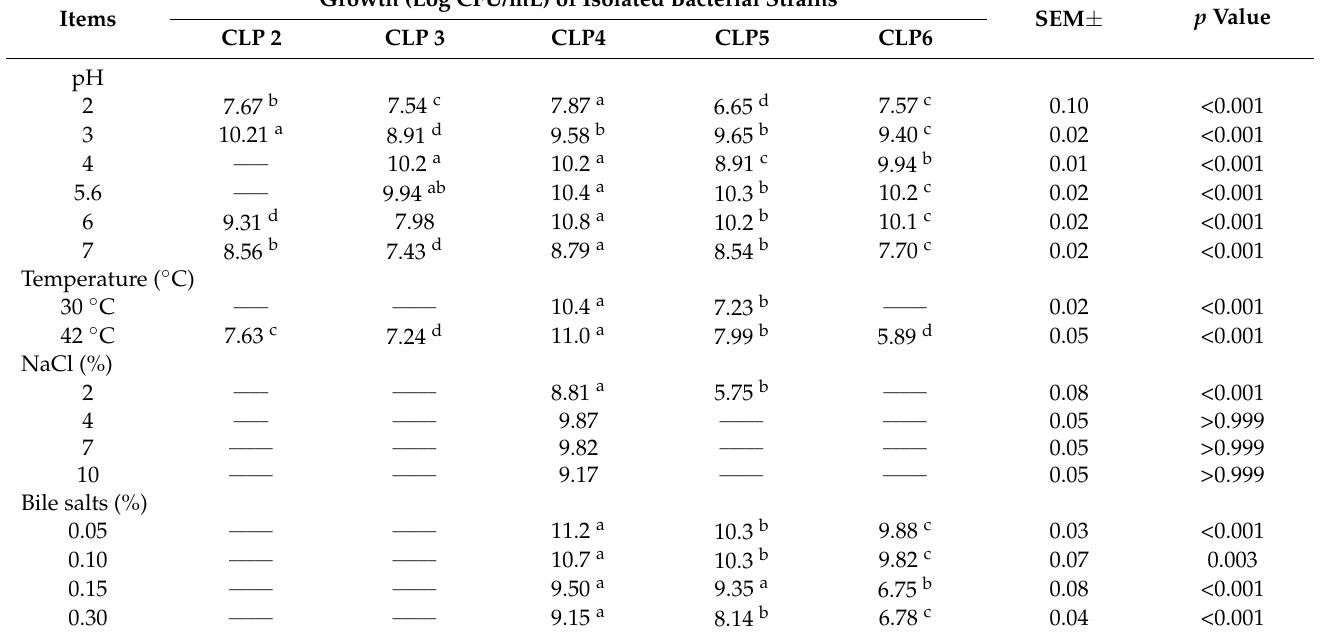
Table 2. In vitro assessment of functional properties of Lactobacillus spp. isolates from the cecal content of Creole roosters under various pH, bile salt, sodium chloride (NaCl), and temperature